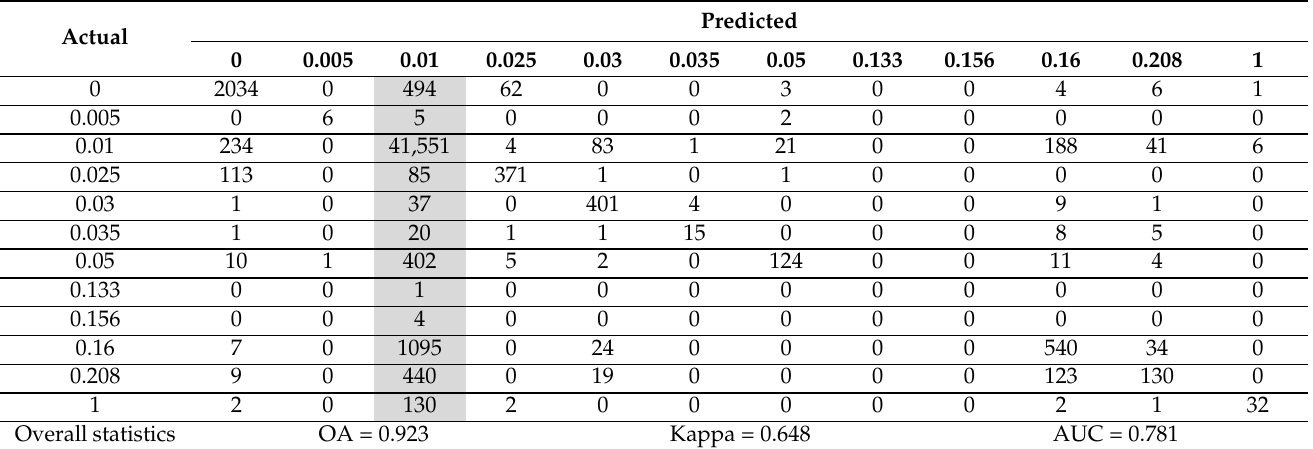
Table 9. The confusion matrix of the test data (2% sampling rate of the majority class).